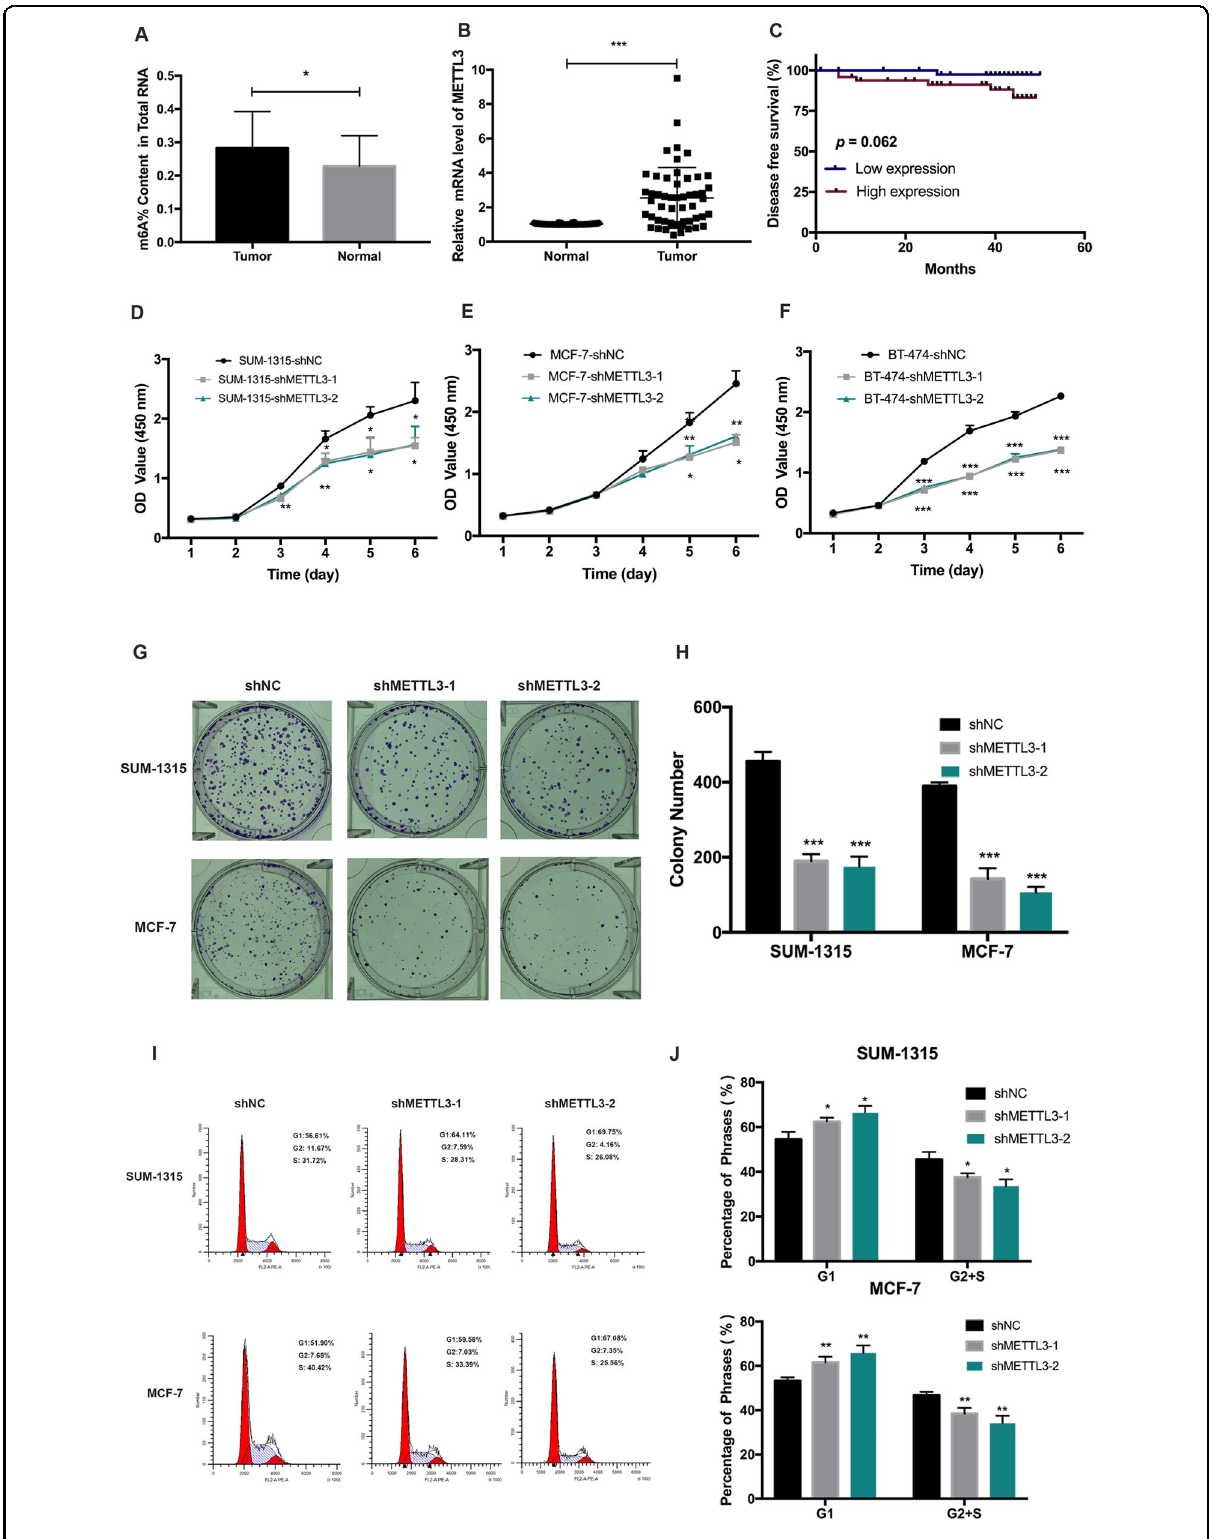
Fig. 2 (See legend on next